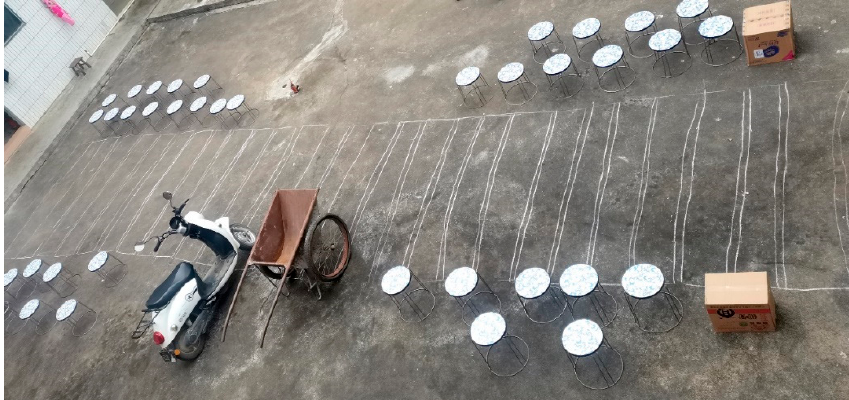
Figure 8. Scene diagram of the inter-group comparison experiment.